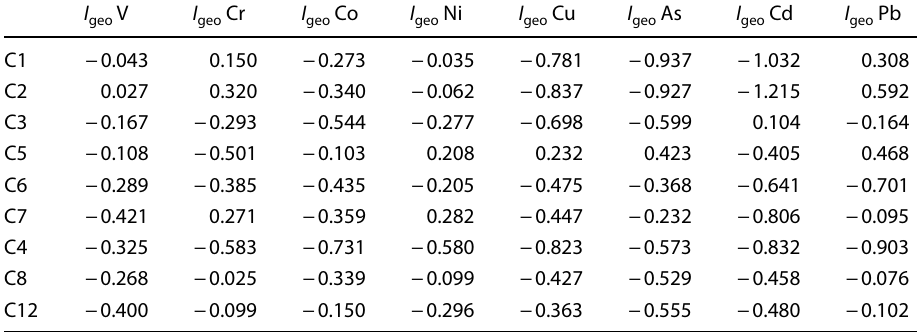
Table 2 Geoaccumulation index ( I ) for Appian Way geo Regional